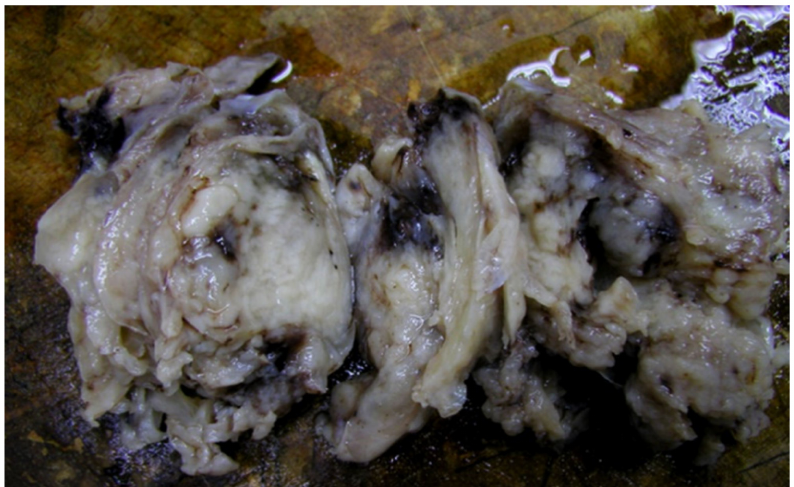
Figure 3. Surgical specimen of the first tumor—gross macroscopic